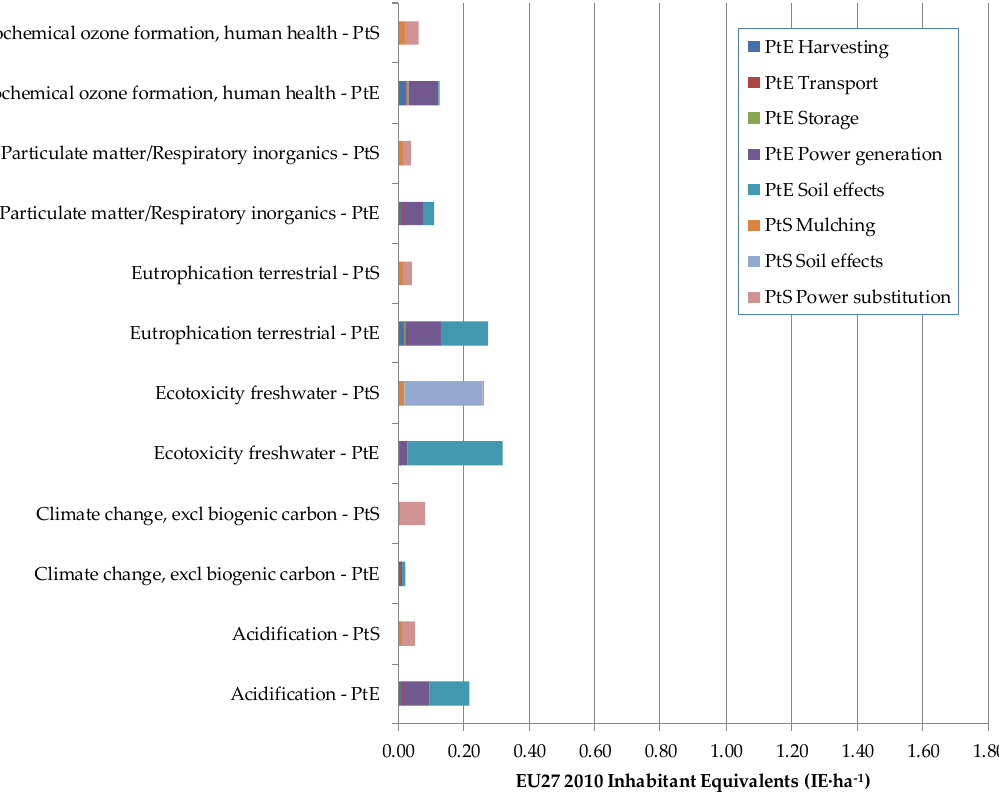
Figure 6. Influence of the change of substituted source of electricity generation: Spanish electricity mix (shown in the PtS scenario) instead of power from hard coal. (theoretical peach pruning potential 2.59 tFM·ha − 1 ).